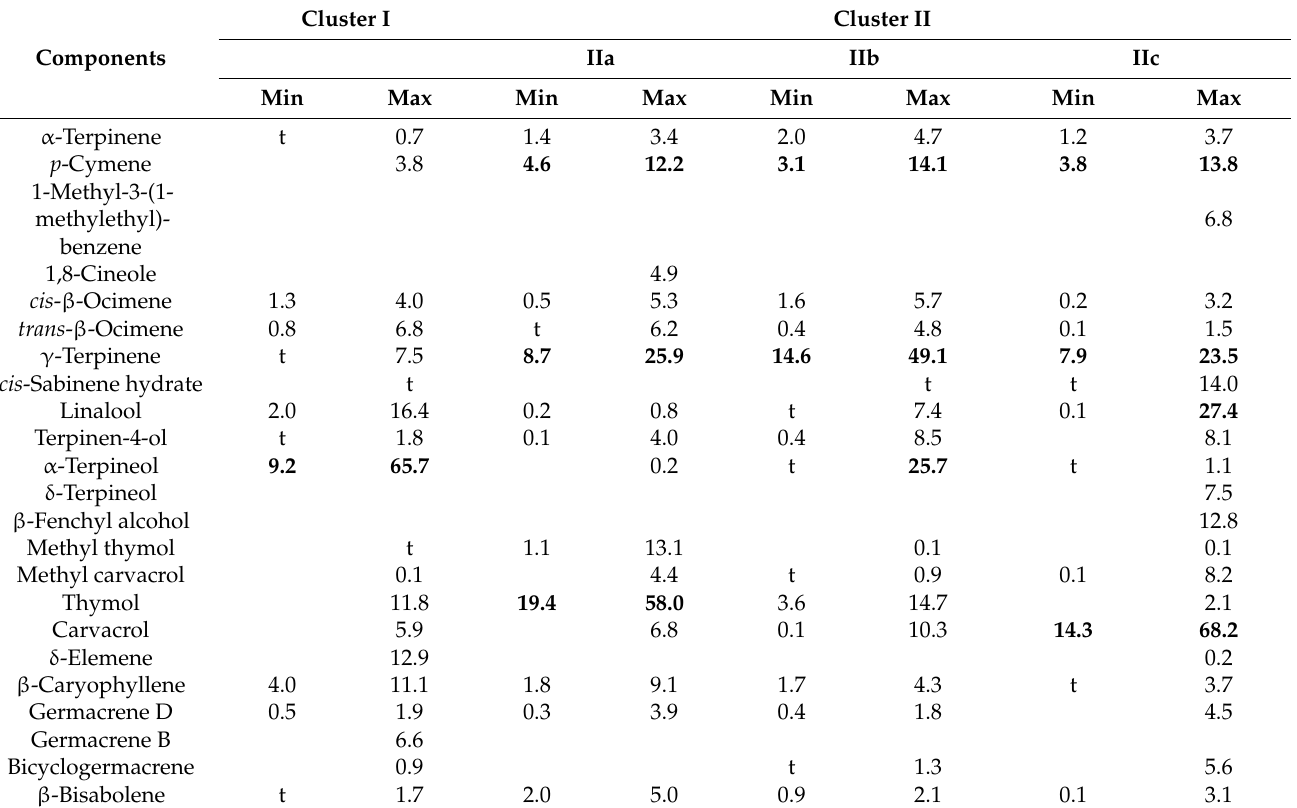
Table 4. Minimum and maximum percentage range of EOs’ main components ( ≥ 5% in at least one sample) from previous studies on Portuguese O. vulgare EOs grouped according to cluster analysis. For samples grouped in each of the clusters and subclusters, vide SM Figure